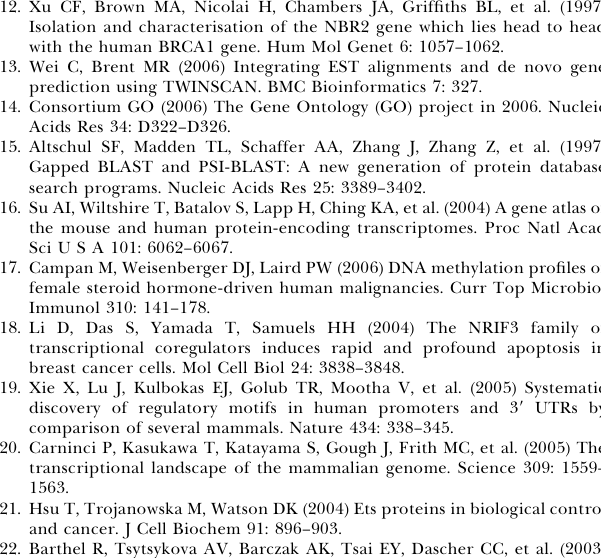
Figure S2. Bidirectional Promoters versus Monodirectional Pro- moters